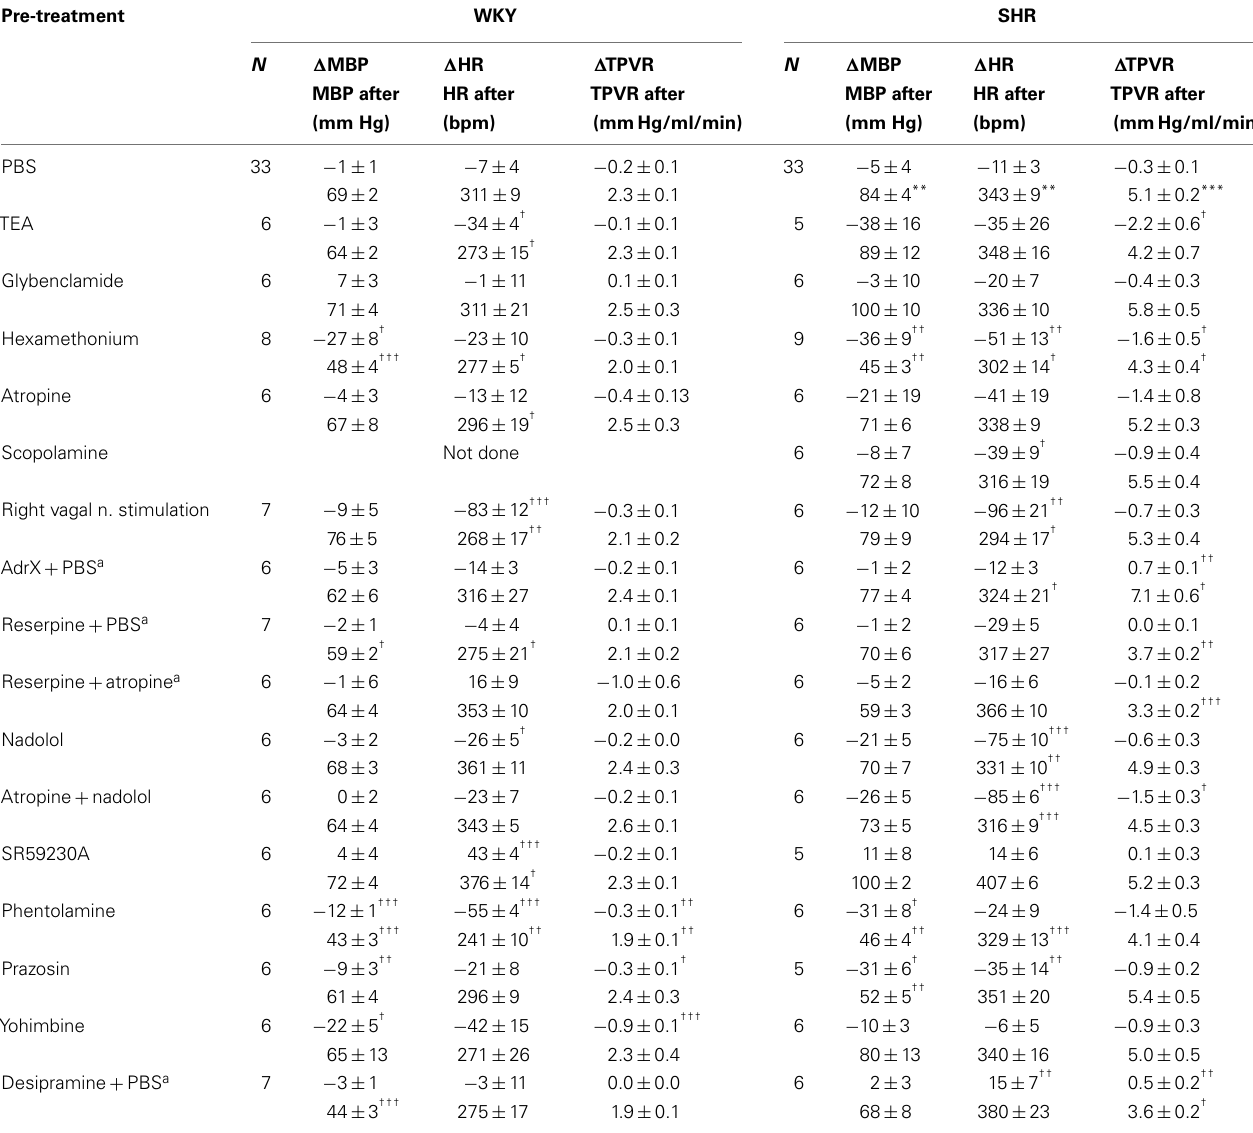
Table 2 |The response to pre-treatment and the resulting MBP, HR, andTPVR after pre-treatment, i.e., baselines prior to